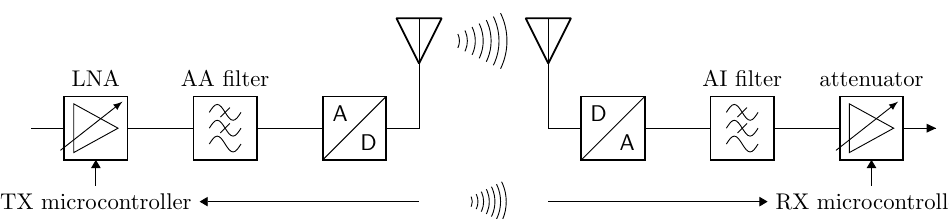
Figure 3. Theoretical operation of the system. The Low Noise Amplifier (LNA) and the programmable attenuator are coordinated by the two microcontrollers (in the transmitter and in the receiver) that cooperate to reconstruct the measured signal. The blocks in the figure represent, from left to right, the LNA, the anti-aliasing filter, the analog-to-digital converter, the digital-to-analog converter, the anti-imaging filter, and the programmable